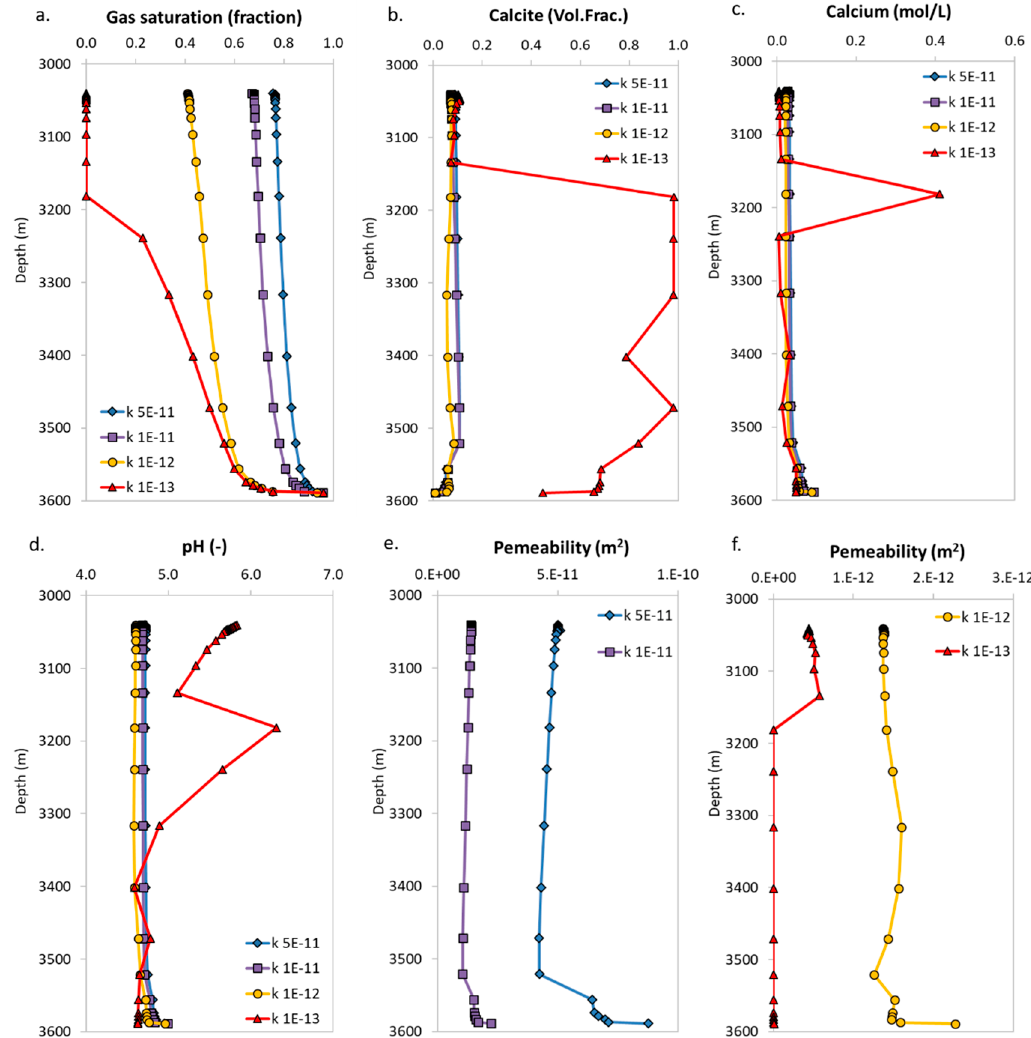
Figure 4. Simulation results along the microannulus for four different initial microannulus permeabilities showing: ( a ) gas saturation, ( b ) calcite volume fraction, ( c ) dissolved calcium, ( d ) pH, and ( e , f ) the permeability of the high and low initial permeability scenarios respectively.